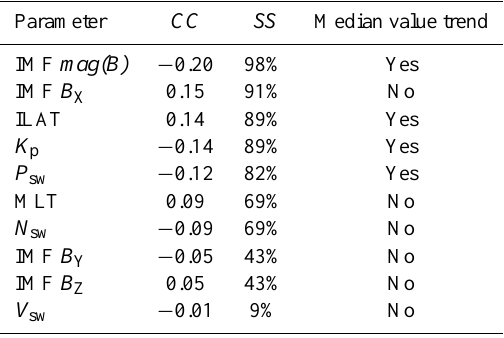
Table 1. Correlation coefficients and statistical significances be- tween the electron edge size and external parameters and indication of the presence of a trend in the median values of the size.